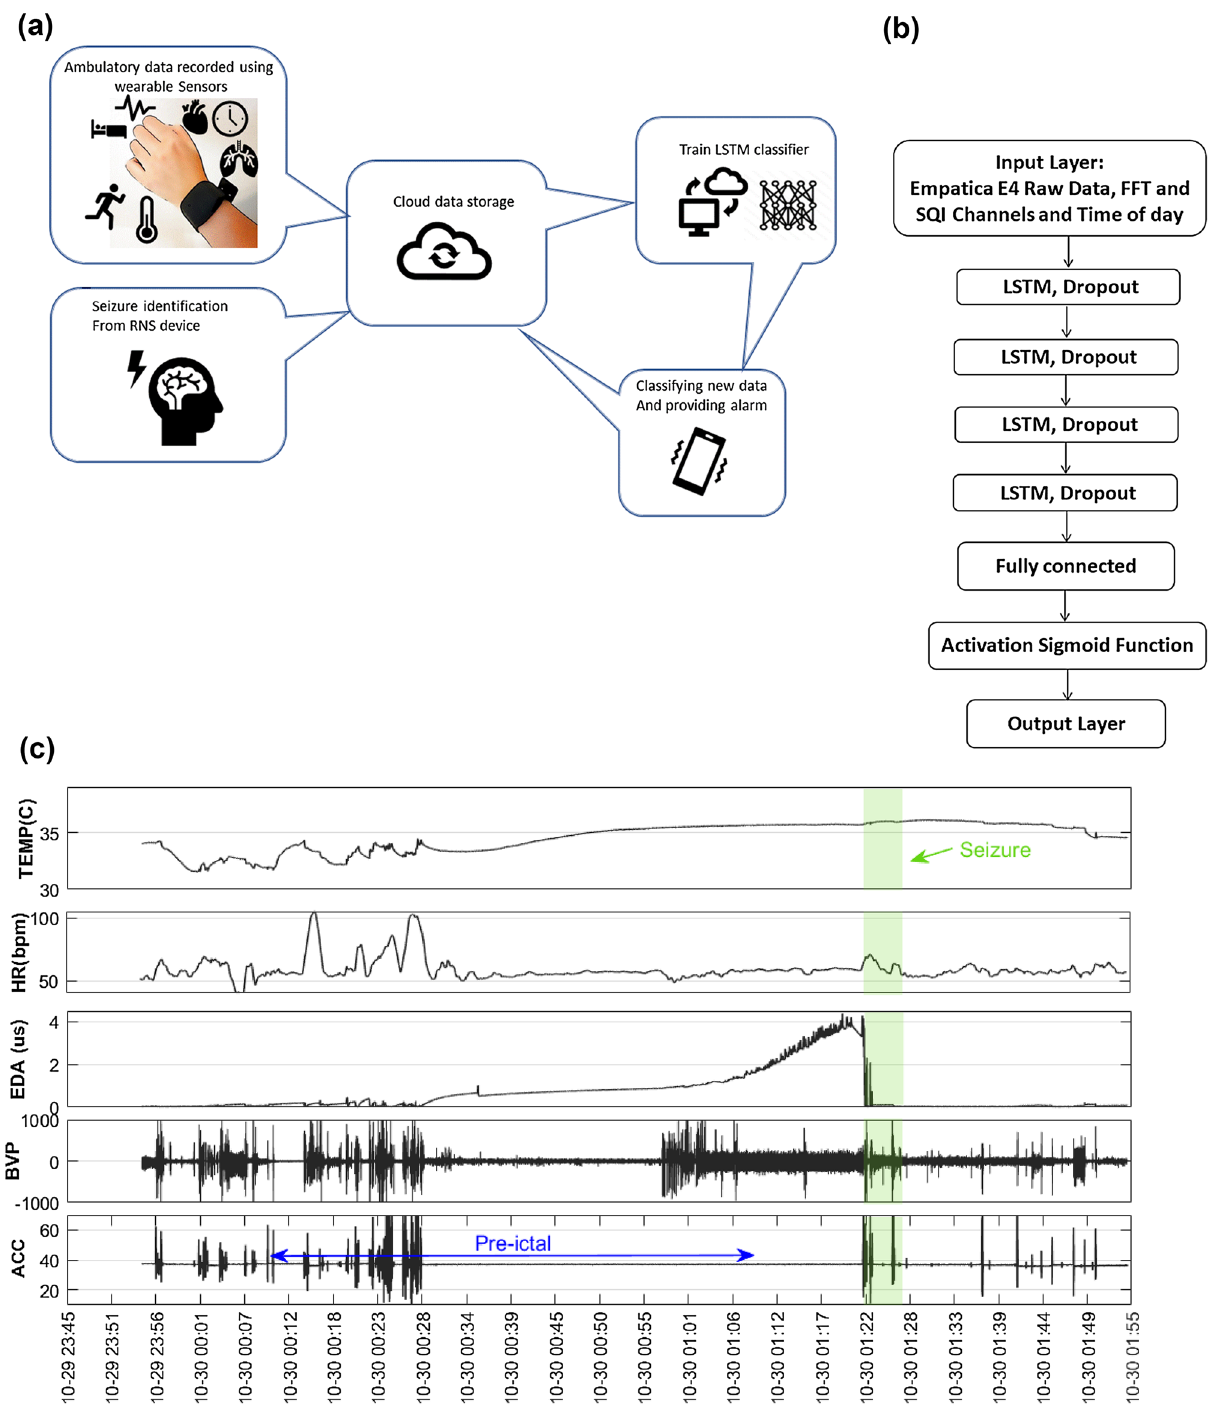
Figure 1. ( a ) Data flow diagram of ambulatory data recorded by wearable sensors, transferred via cloud storage, and analyzed using deep learning. Ambulatory data recorded using Empatica E4 wristbands was uploaded regularly to cloud storage by patients and was downloaded by study staff. Patients uploaded RNS data as part of routine clinical care, and the iEEG clips were reviewed for seizure activity. ( b ) Architecture of machine learning classifier with 4 LSTM layers, 128 hidden nodes, one dropout layer after each LSTM layer with a dropout rate of 0.2, a fully connected layer, and an output layer to generate the classification output using a sigmoid activation function. ( c ) Raw wearable data plotted showing accelerometry, EDA, temperature, and blood volume pulse with derived heart rate for a preictal segment from 75 to 15 min before the approximate seizure time